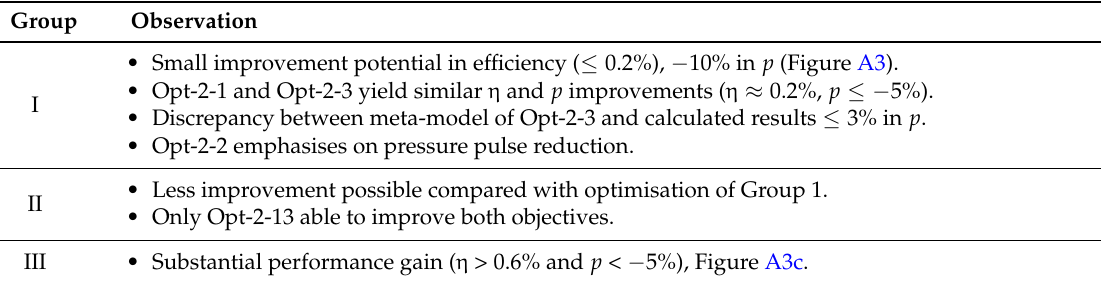
Table 8. Potential improvement and convergence observations of Opt-2.